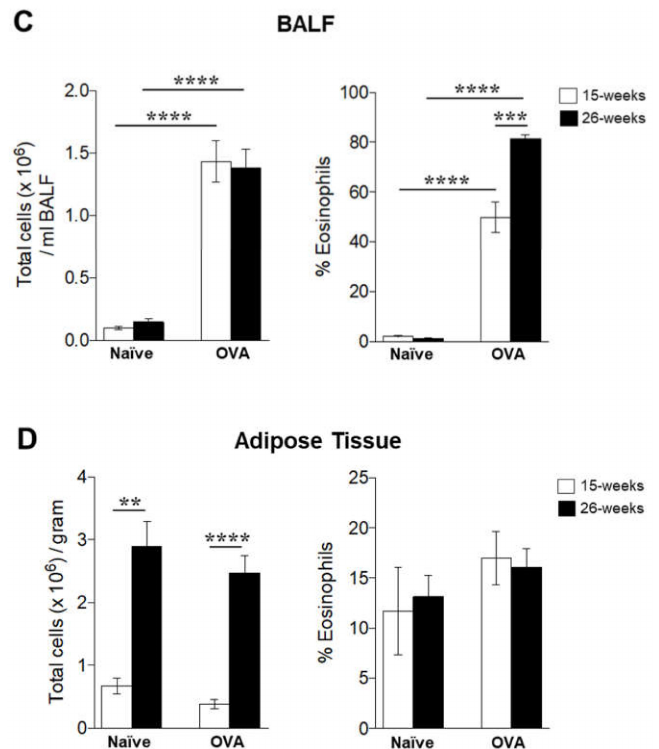
Figure 4. The induction of allergic lung inflammation in DIO mice on di ff erent grades of obesity. ( A ) The experimental design for sensitization and challenge with ovalbumin (OVA) in mice on a high-fat diet (HFD) up to 15 weeks of age (overweight model) or 26 weeks of age (morbid obesity model). The model of allergic lung inflammation was induced in DIO mice during the last three weeks of HFD feeding. ( B ) Comparison of the body weight in mice on a HFD up to 15 weeks or 26 weeks of age (left) and the terminal body weight (right). Total inflammatory cells (left) and eosinophils (right) in ( C ) bronchoalveolar lavage fluid (BALF), and ( D ) adipose tissue obtained from DIO naïve and allergic mice. Data are means ± SEM of n = 3–4 mice per group. One-way ANOVA followed by Bonferroni’s multiple comparisons test, ** p < 0.01*** p < 0.001, and **** p < 0.0001. DIO, diet-induced obesity; HFD, high-fat diet; and OVA,